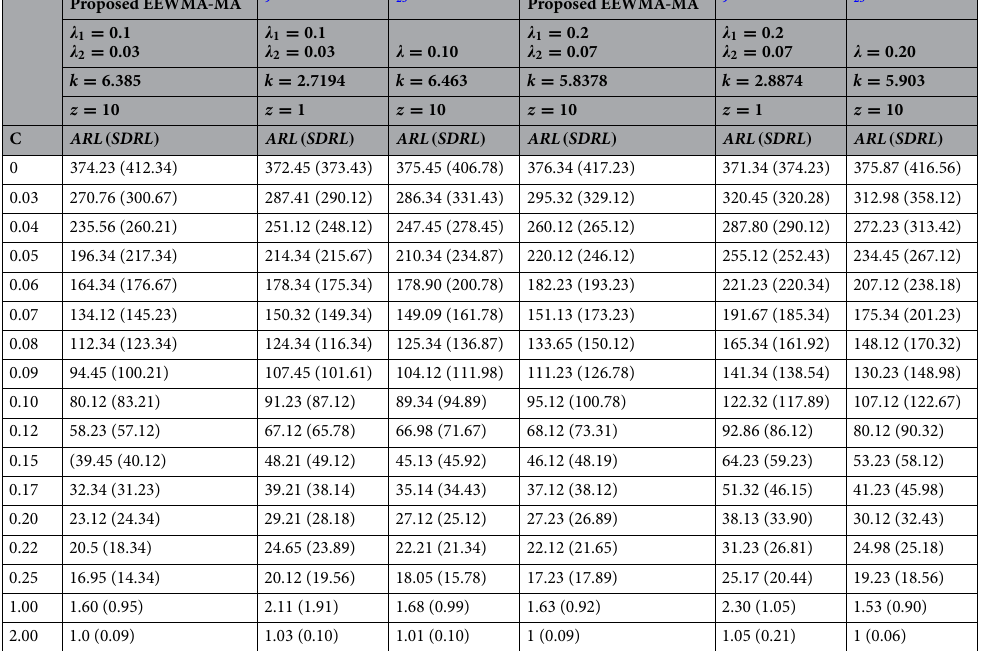
Proposed EEWMA-MA